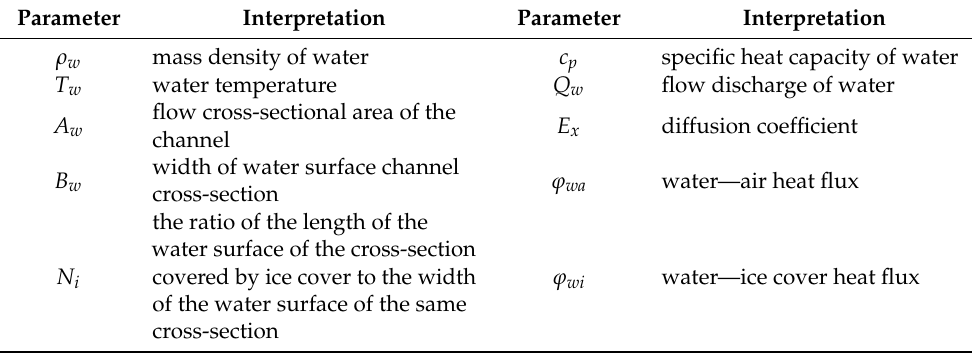
E x diffusion coefficient ϕ wa water—air heat flux ϕ wi water—ice cover heat